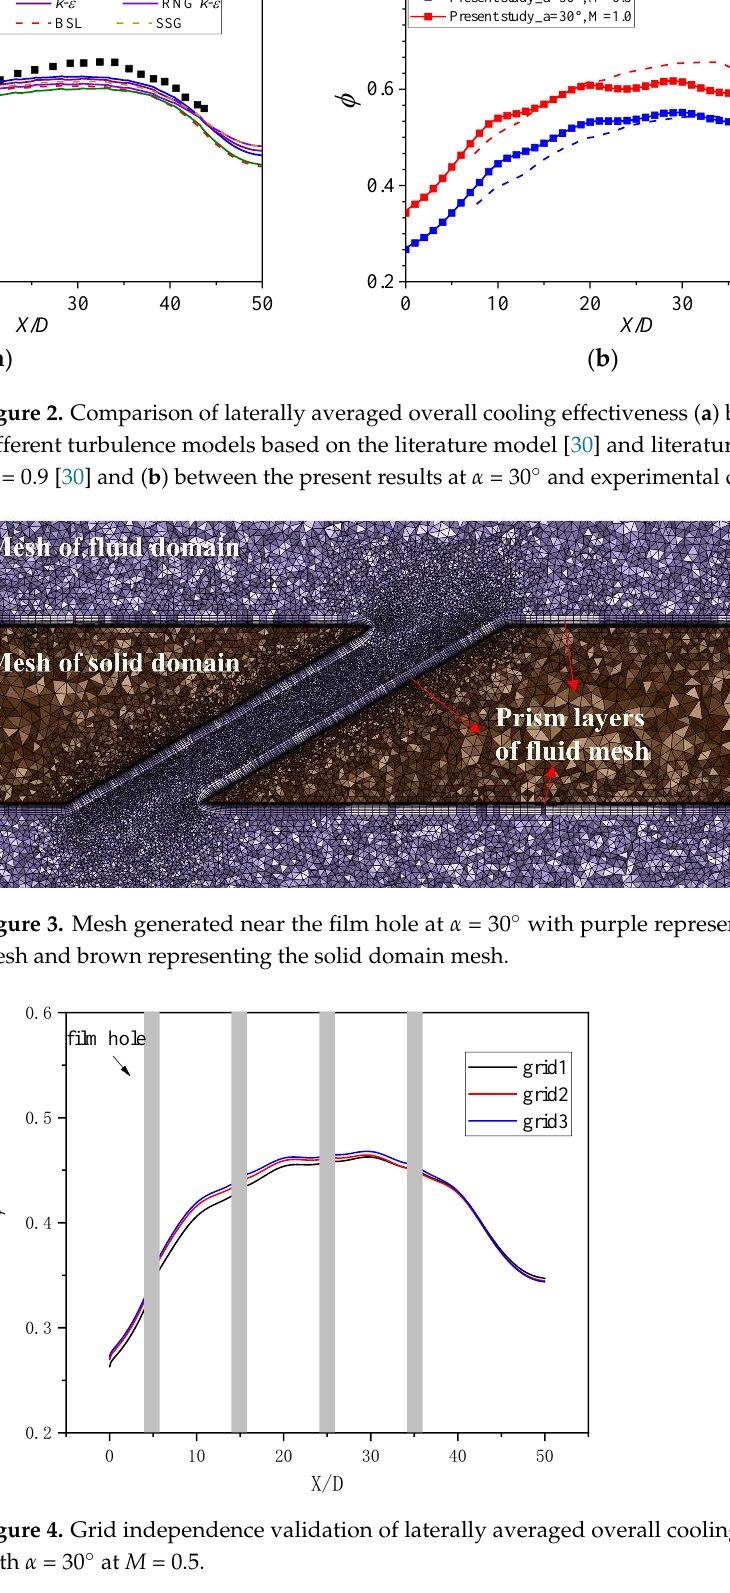
Figure 2. Comparison of laterally averaged overall cooling effectiveness ( a ) between CFD results of different turbulence models based on the literature model [30] and literature experimental data at M = 0.9 [30] and ( b ) between the present results at α = 30° and experimental data [30] at different M .